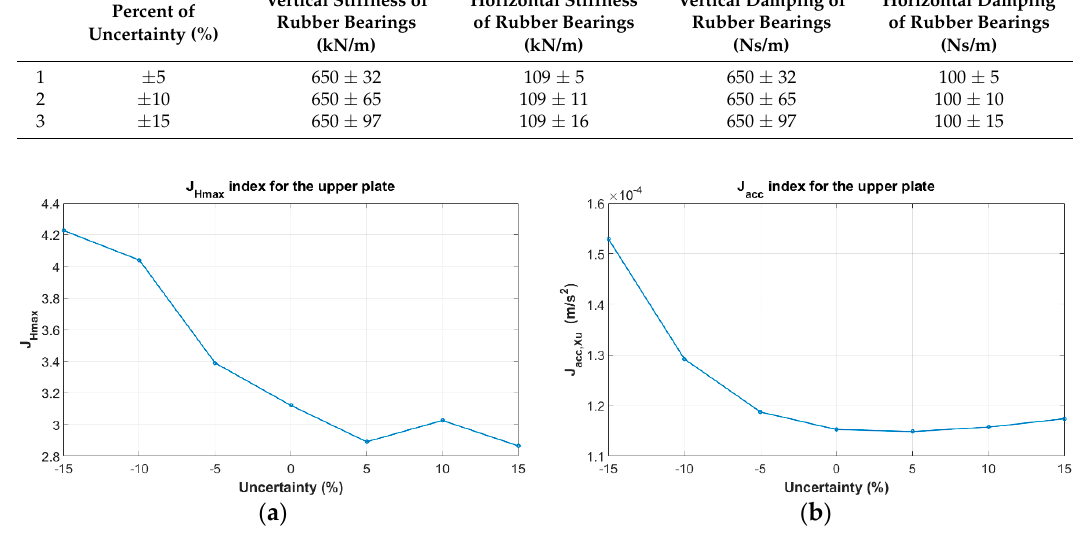
Figure 18. Indices for the upper plate in the presence of uncertainties in the structural parameters: ( a ) J Hmax ; and ( b ) J acc , Xu . Machines 2017 , 5 , 33